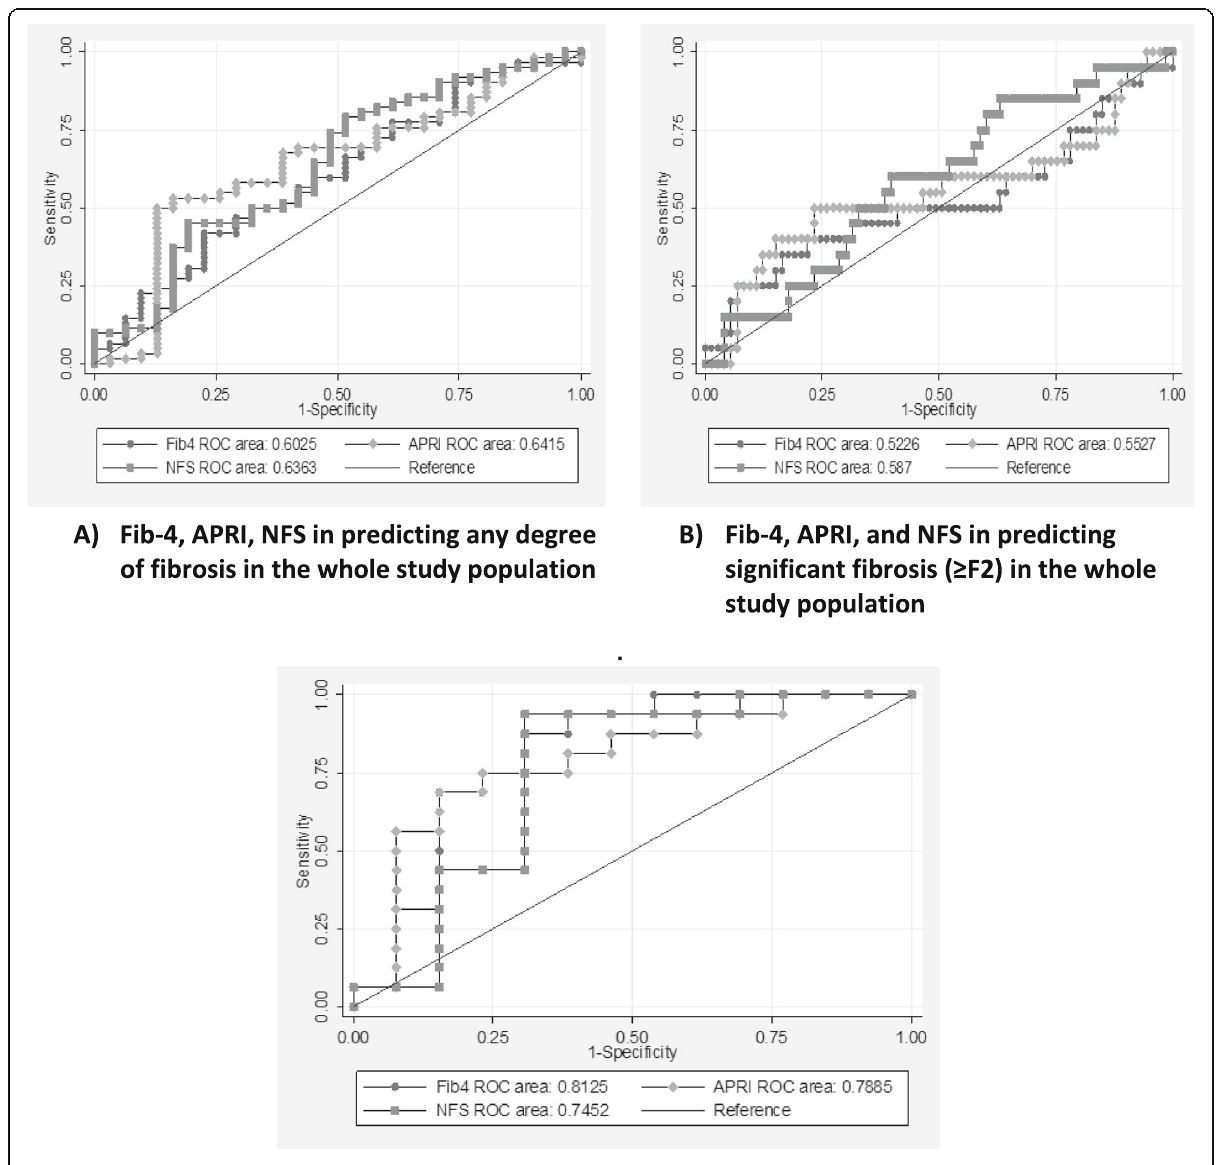
Fig. 1 ROC curves for predictivity of FIB4, APRI, NFS of different degrees of fibrosis. ( A ) Fib-4, APRI, NFS in predicting any degree of fibrosis in the whole study population. ( B ) Fib-4, APRI, and NFS in predicting significant fibrosis ( ≥ F2) in the whole study population. ( C ) Fib-4, APRI, NFS in predicting any degree of fibrosis in the subset of patients with simple steatosis (NAS <